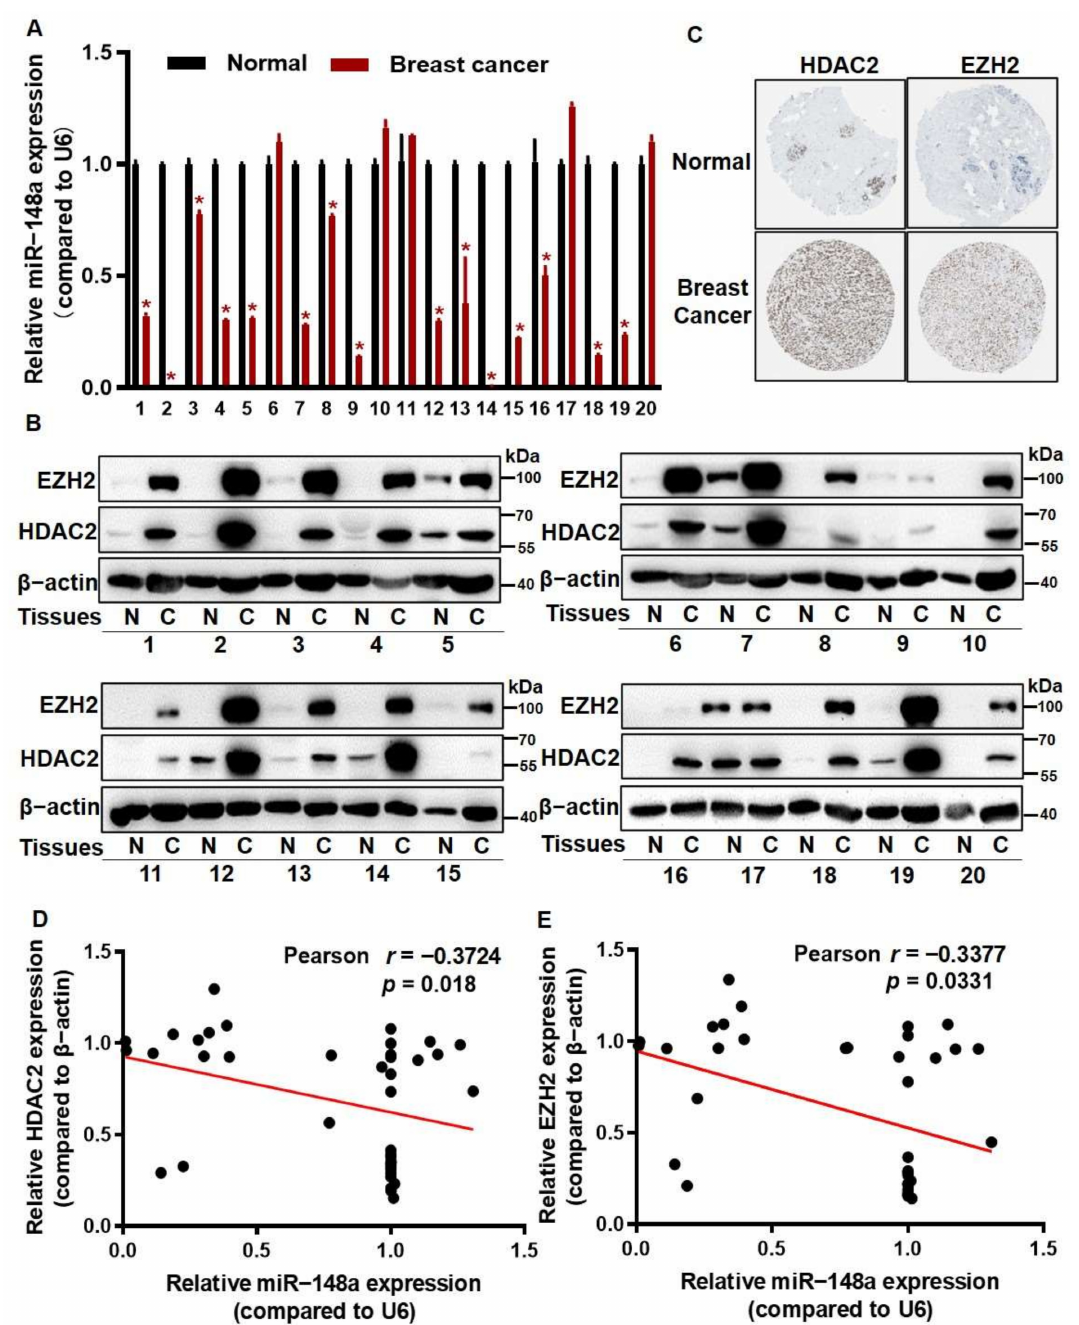
Figure 5. The levels of HDAC2 and EZH2 were inversely correlated with miR-148a levels in breast cancer tissues. ( A ) The expression levels of miR-148a were detected in 20 pairs of tissues by qRT-PCR. ( B ) EZH2 and HDAC2 protein expression levels were measured in 20 pairs of human breast cancer tissues and their corresponding normal breast tissues (N) by Western blotting. ( C ) The results from Human Protein Atlas showed a stronger staining of HDAC2 and EZH2 in breast cancer tissues than in normal tissues. ( D , E ) Pearson’s correlation analysis between miR-148a and HDAC2 ( D ) or EZH2 ( E ) in 20 pairs of tissues (HDAC2, r = − 0.3724, p = 0.018) (EZH2, r = − 0.3377, p = 0.0331). For human tissue samples, Student’s paired two-tailed t -test was used to analyze the comparison between different groups. * Indicates significant difference at p < 0.05. Original Blots see Supplementary File